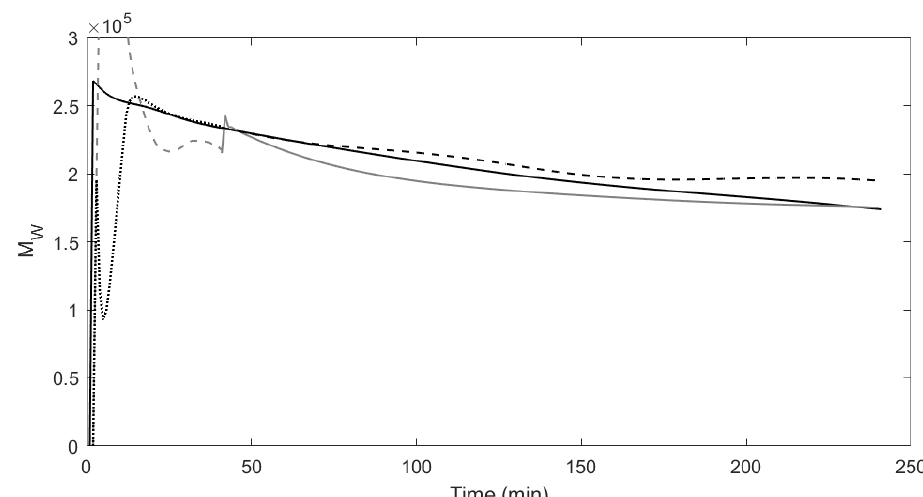
Figure 6. The weight average molecular weight predictions from both models with every tenth quality measurement retained and 20% missing output data. The dashed grey lines represent estimates made by the Luenberger observer until the 40th minute and the solid grey line shows the predictions from the proposed approach in comparison to the process, represented by the solid black line. The dotted and dashed black lines show the estimates made by the Luenberger observer and traditional subspace identification using linear interpolation,